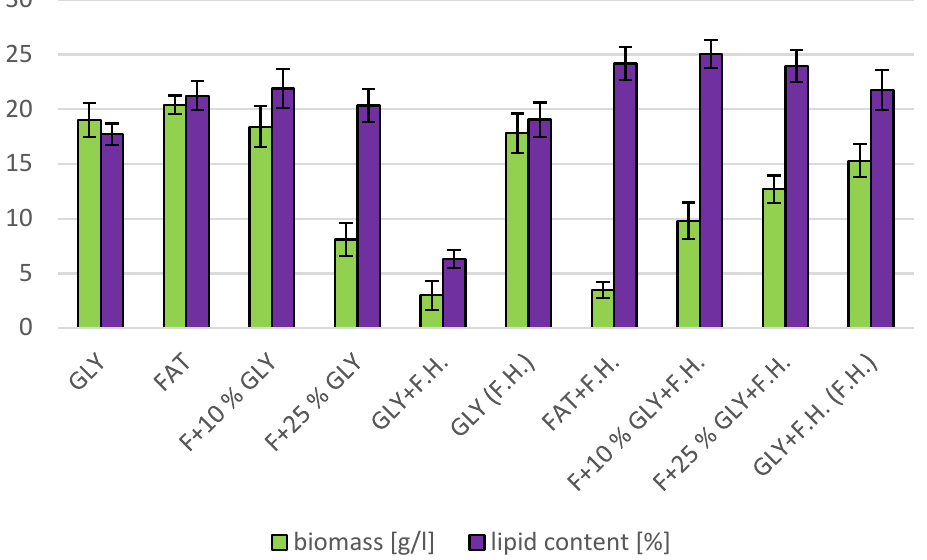
Figure 1. Metabolite production by biomass of yeast strain Rhodotosporidium toruloides in conditions of C/N ratio 25.